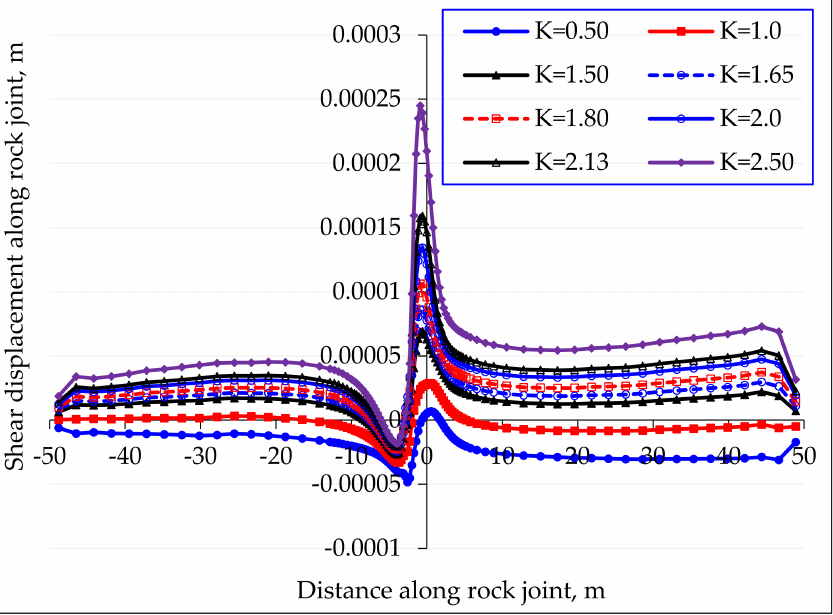
Figure 14. Shear displacements along a rock yielded joint that runs below the tunnel opening at various in situ stress ratios